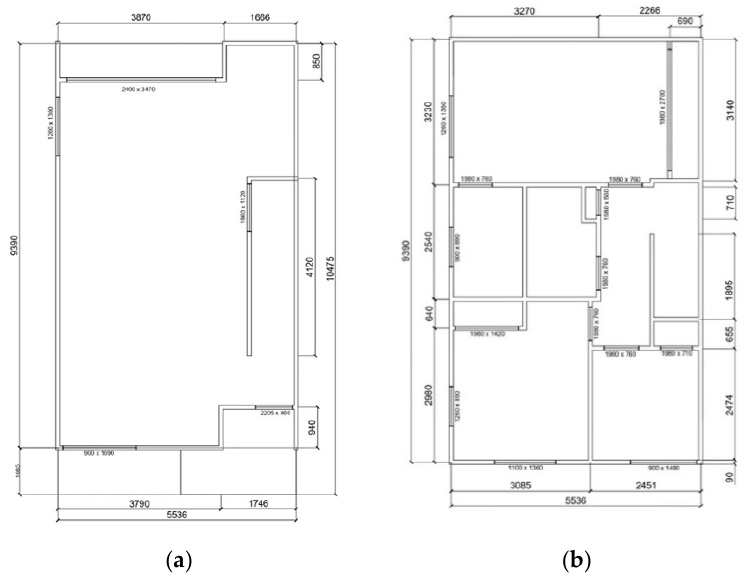
Figure 3. House A—light timber house plan ( a ) ground floor; ( b ) upper floor (all measurements are in millimetres and scaled at 1:100).